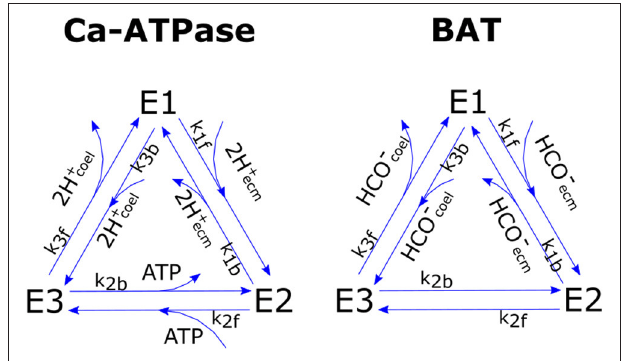
FIGURE 2 | Graphic scheme of the two cyclic enzymatic reactions that were used to model Ca-ATPase and BAT membrane transport proteins.